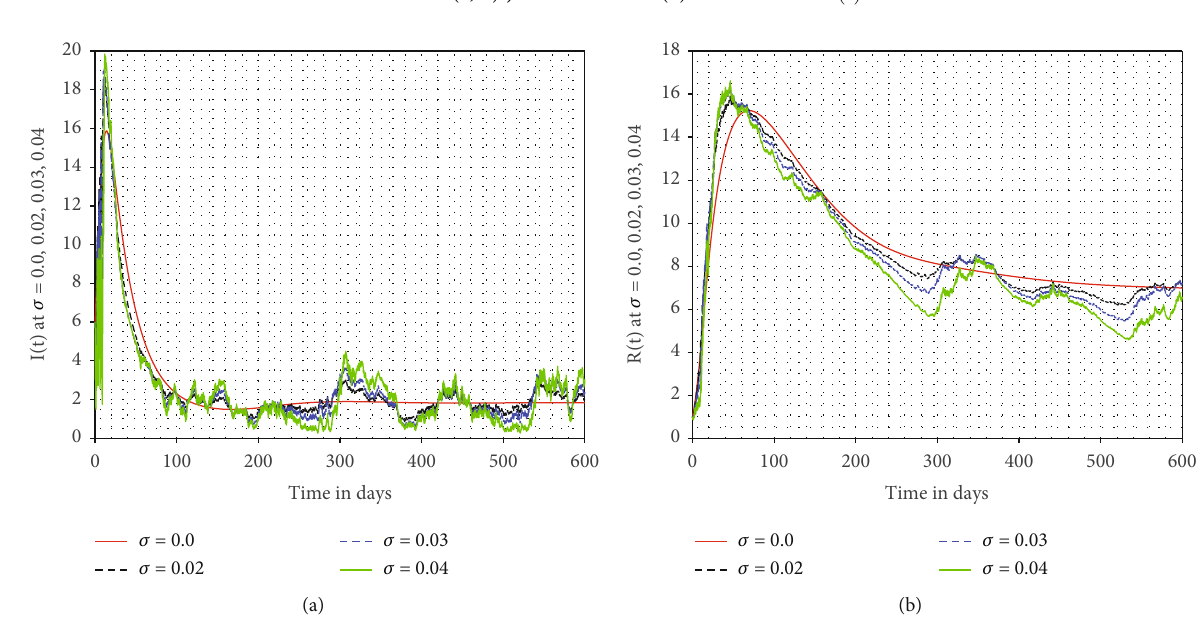
Figure 3: (a, b) Joint solution of (1) at σ = 0 : 0 and S ð t Þ .